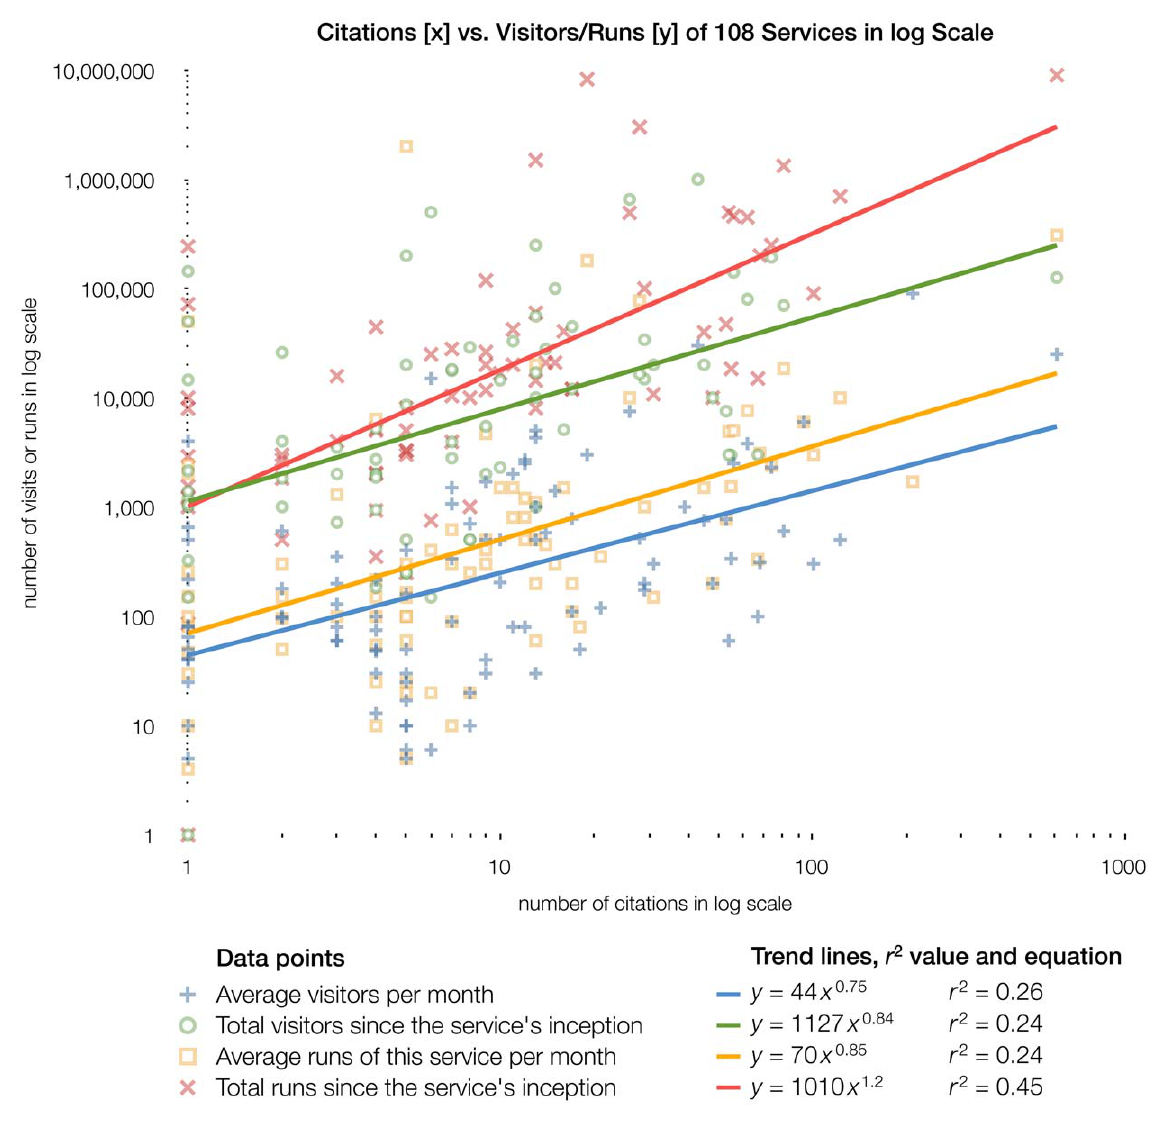
Figure 6. Number of citations listed in PubMed Central plotted against that service’s number of visitors and runs. 108 of the 274 respondents (39%) to the author survey chose to answer the optional question about the Web address of their service and also gave numbers for monthly and total visits and runs. We combined this information with the number of times a service is cited in articles deposited in PubMed Central. Plotting these information against each other in log scale reveals relationships, shown as trend lines. The data points are based on the information given by the authors of the service themselves.